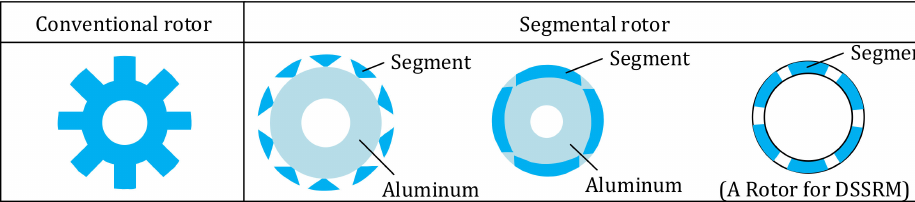
Figure 5. Different rotor structure of an SRM.